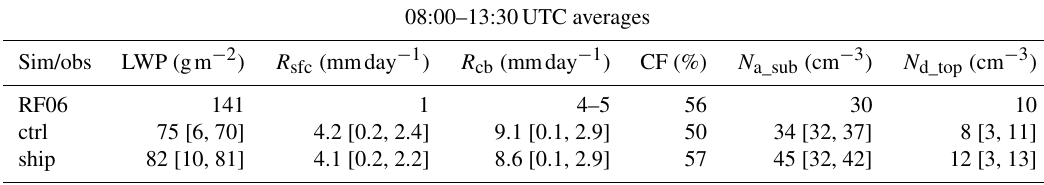
Table 1. Spatio-temporal averages of liquid water path (LWP), surface precipitation ( R sfc ), cloud base precipitation ( R cb ), cloud fraction (CF), sub-cloud mean boundary layer aerosol concentration ( N a_sub ) and cloud-top droplet number concentration ( N d_top ) are presented. The first row containing data shows the observations of the open-cell stratocumulus deck obtained during research flight RF06 of the VOCALS- Rex campaign on 28 October 2008 between 08:00 and 13:30UTC. The numerical results, shown in the last two rows, were averaged over the identical time periods over both simulated days. Domain-mean values were computed for LWP, CF and N a_sub . R sfc was averaged only over values exceeding 0.1mmday − 1 and R cb was averaged for all R cb > 0mmday − 1 (consistent with observations). N d_top was diagnosed at the highest model level where cloud water content exceeded 0.01gm − 3 and was averaged horizontally (cloudy points only). Numbers in brackets denote the interquartile range of each variable, which covers the spatial and temporal variability of the cloud field. Numerical results are shown for the control simulation (ctrl) and the aerosol perturbed simulation (ship). Further details on simulations can be obtained in the